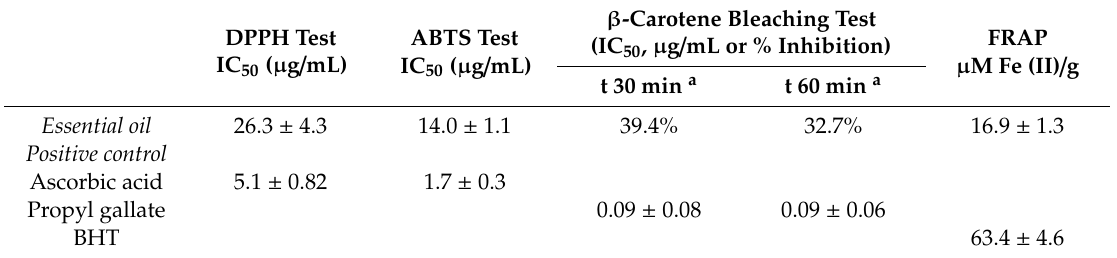
Table 2. The antioxidant potential of F. nodosa subsp. geniculata